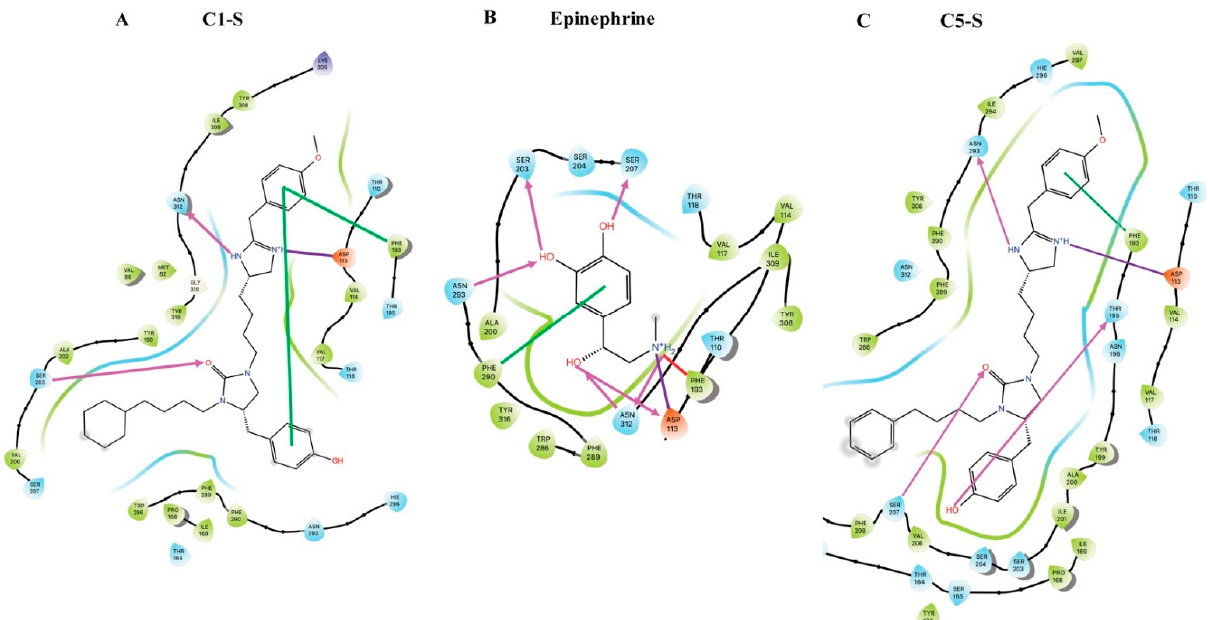
Figure 7. Pharmacophores showing the predicted binding sites for the agonists C1-S, epinephrine, and C5-S at the activated β 2 AR. See the text for comparisons. ( A ) C1-S binding sites include hydrogen bond (pink arrows) to Ser203 5.42 and Asn312 7.39 ; salt bridge (purple line) to Asp113 3.32 ; and Pi–Pi stacking at Phe193 ECL2 with an internal aromatic bond (green line). ( B ) Epinephrine binding sites include hydrogen bond to Ser203 5.42 , Ser207 5.46 , Asn293 6.55 , Asn312 7.39 and Asp113 3.32 ; salt bridge to Asp113 3.32 ; cation– π interaction with Phe193 ECL2 ; and a π -stacking interaction with Phe290 6.52 . ( C ) The C5-S binding site includes hydrogen bond to Ser203 5.42 , Asn293 6.55 , and Thr195 ECL2 , salt bridge to Asp113 3.32 ; Pi-stacking at Phe193 ECL2 with an internal aromatic bond. Ligand atoms that are exposed to solvent are marked with gray spheres.